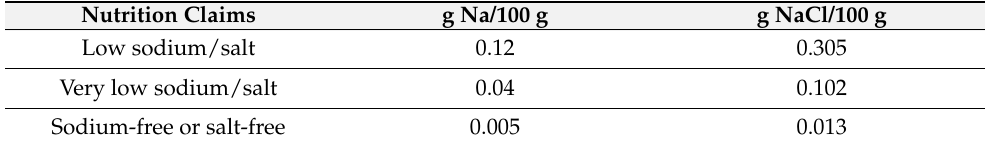
Table 1. The nutrition claims related to sodium and salt content